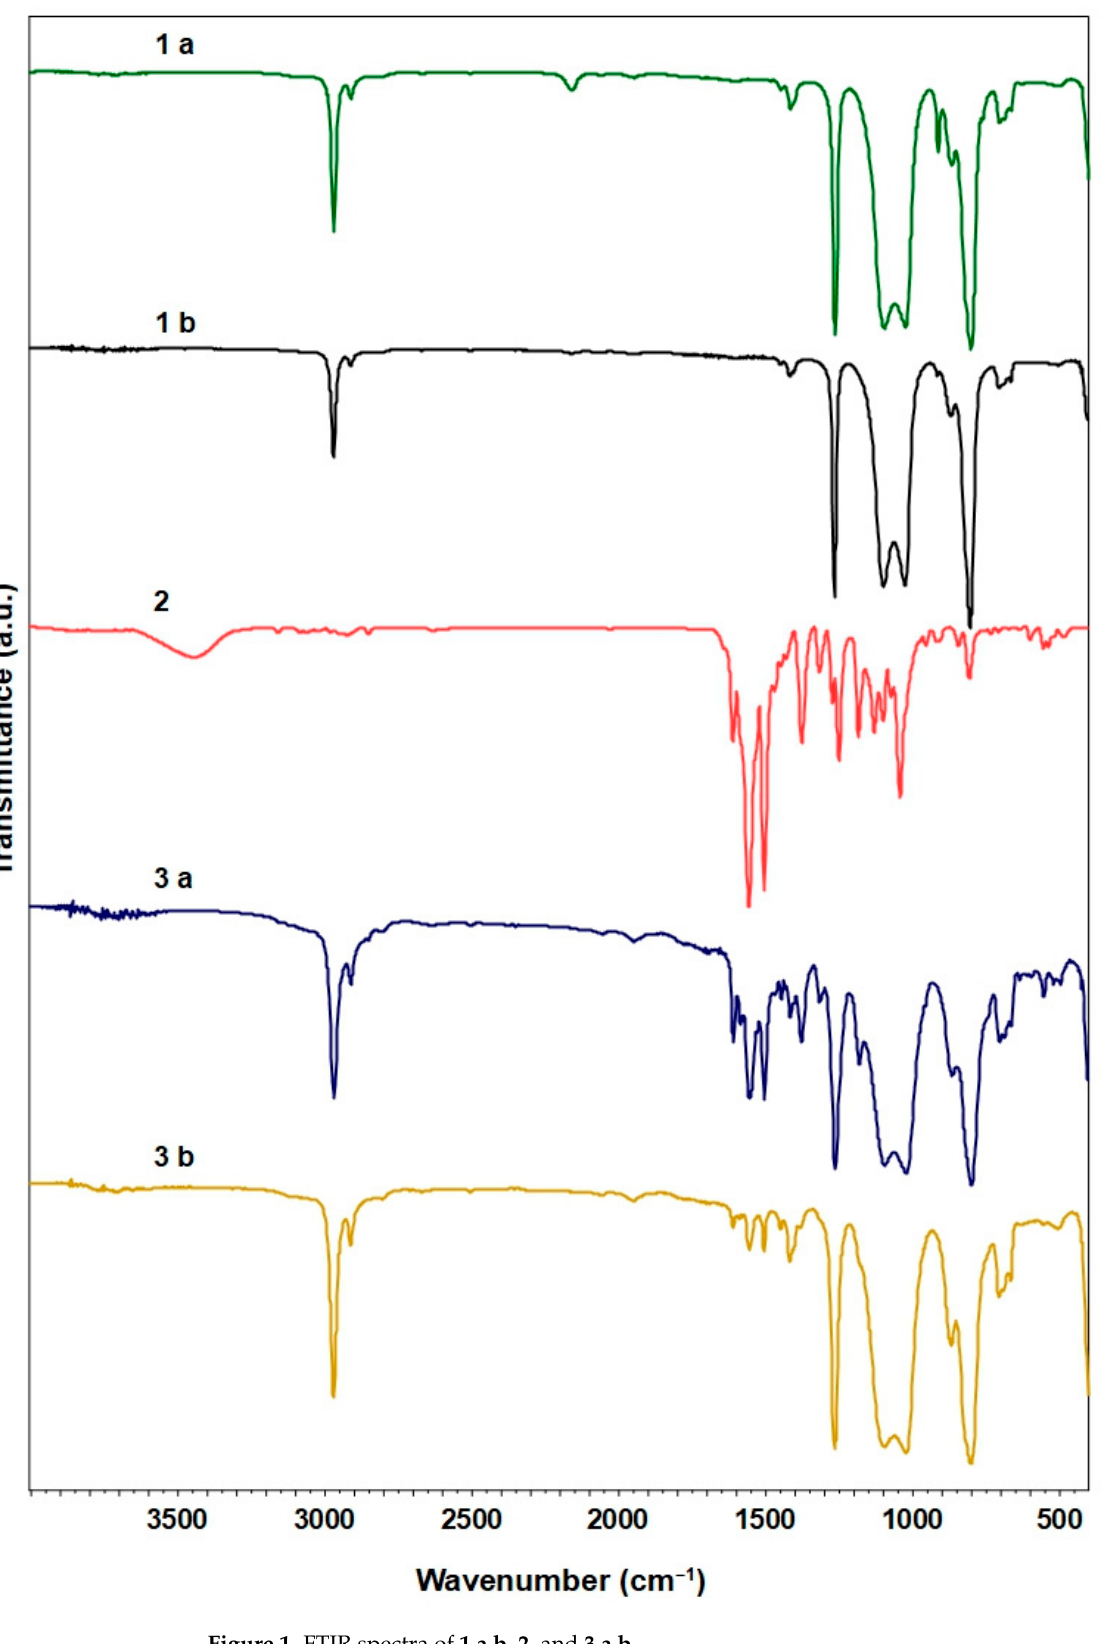
Figure 1. FTIR spectra of 1 a,b , 2 , and 3 a,b .